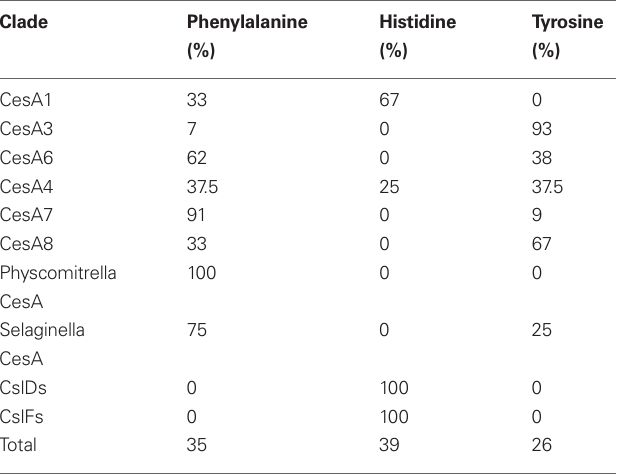
Table 6 | Amino acids observed at first identified aromatic residue.